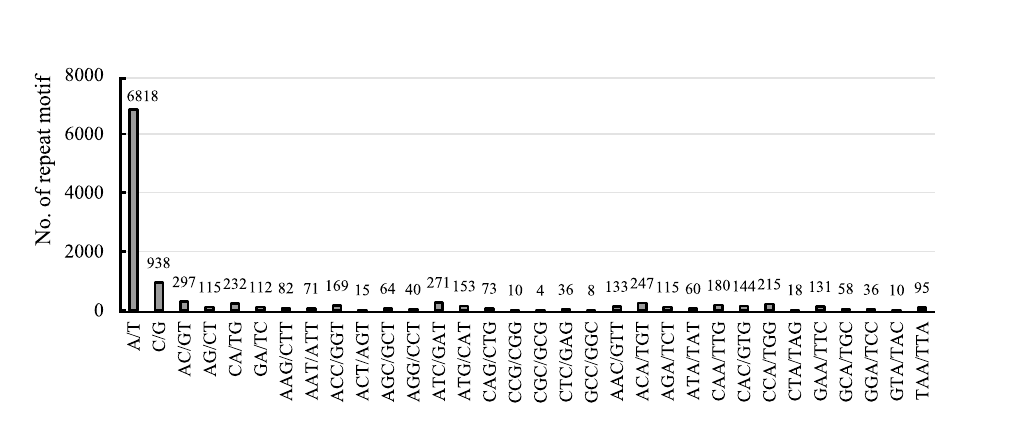
Figure 1. Numbers of mono-, di-, and trinucleotide repeat